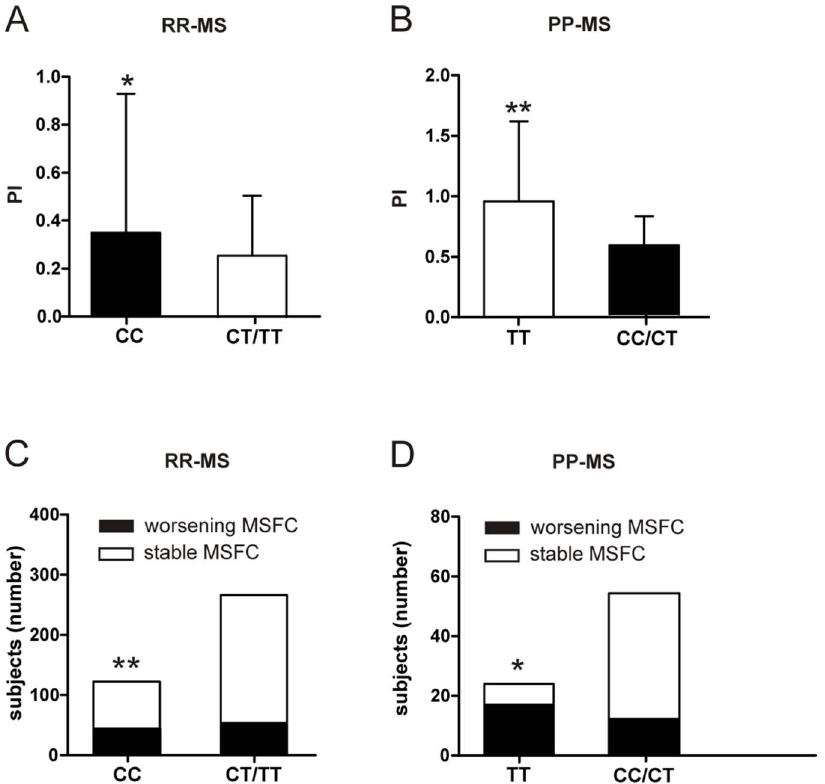
Figure 2. Effect of SNP rs4880213 on disability progression in MS. A. The graph shows that PI was lower among RR-MS patients with T allele. B. PI was higher among PP-MS subjects homozygous for T allele. C. Disability progression at MSFC was less frequent among RR-MS patients with T allele. D. The graph shows that early disability progression at MSFC (in the first two years of the disease) was more frequent among PP-MS subjects homozygous for T allele. * means p , 0.05; ** means p , 0.01.